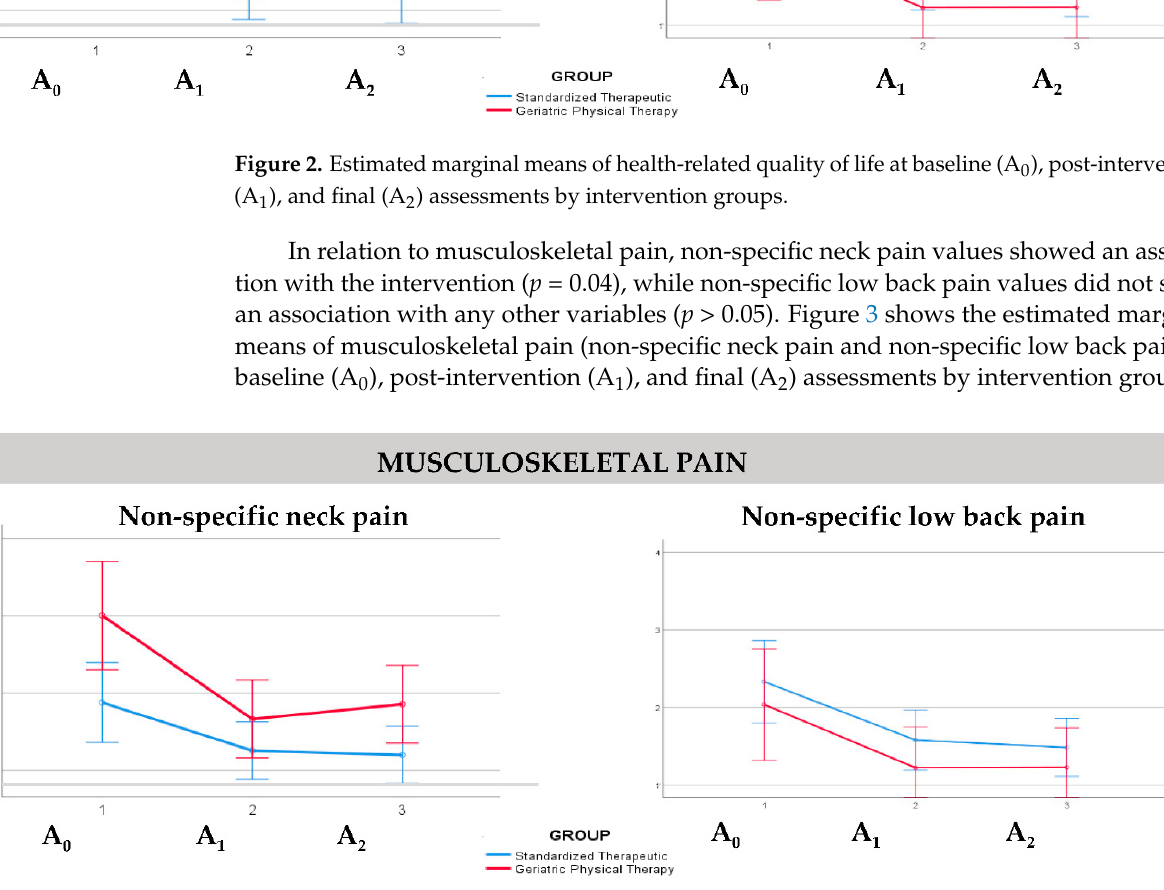
0 ), post-intervention